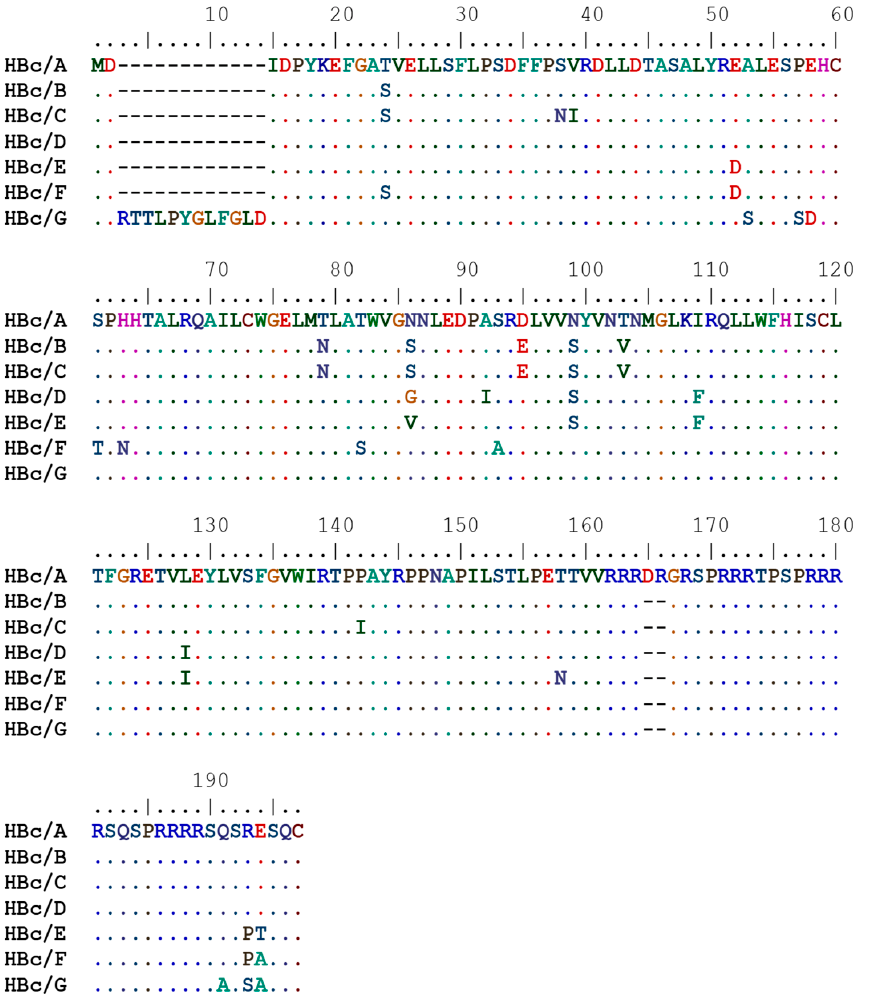
Figure 1. Amino acid sequences of the core proteins (HBc) of hepatitis B virus (HBV) genotypes A, B, C, D, E, F, and G used in this work.